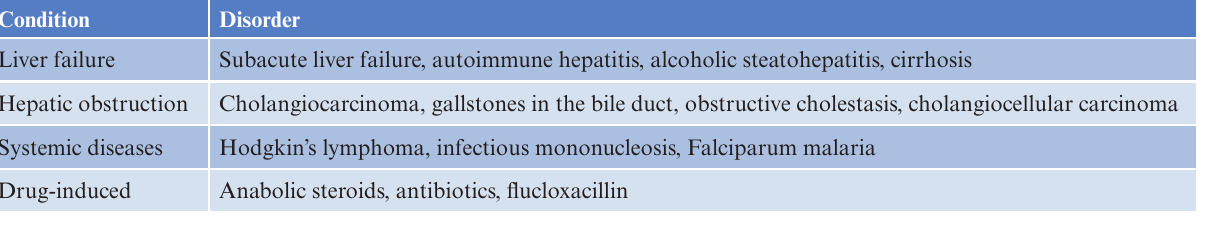
Table 2. Disorders reported in cholemic nephropathy